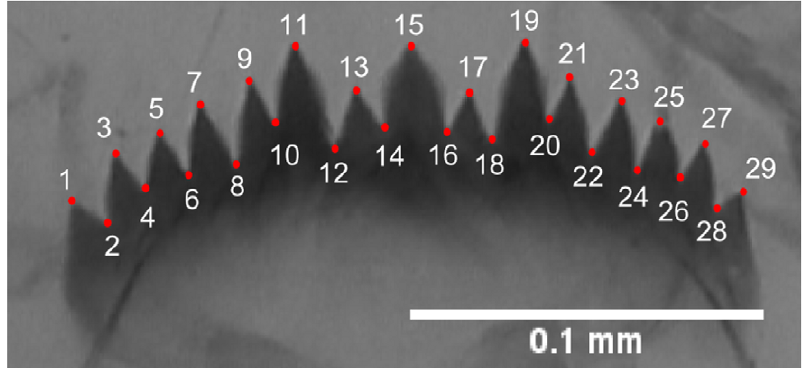
Figure 4. The 29 landmarks digitized on each mentum to measure shape FA.